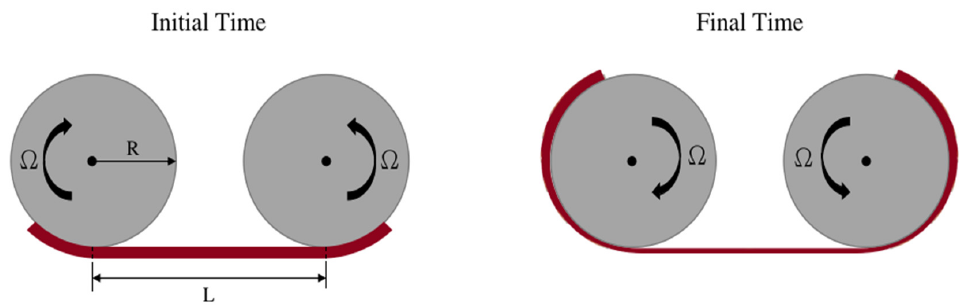
Figure 1. A schematic top view representation of the extensional test in the SER platform. The imposed Hencky strain rate (